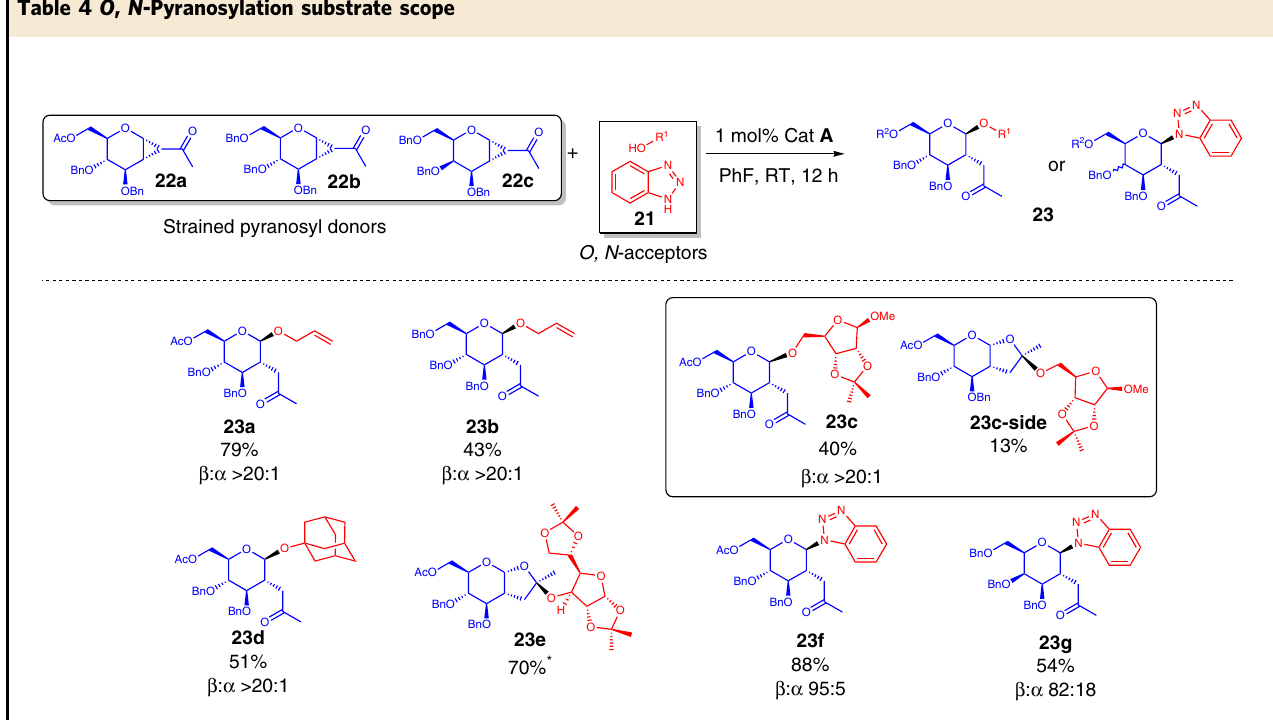
Table 4 O , N -Pyranosylation substrate